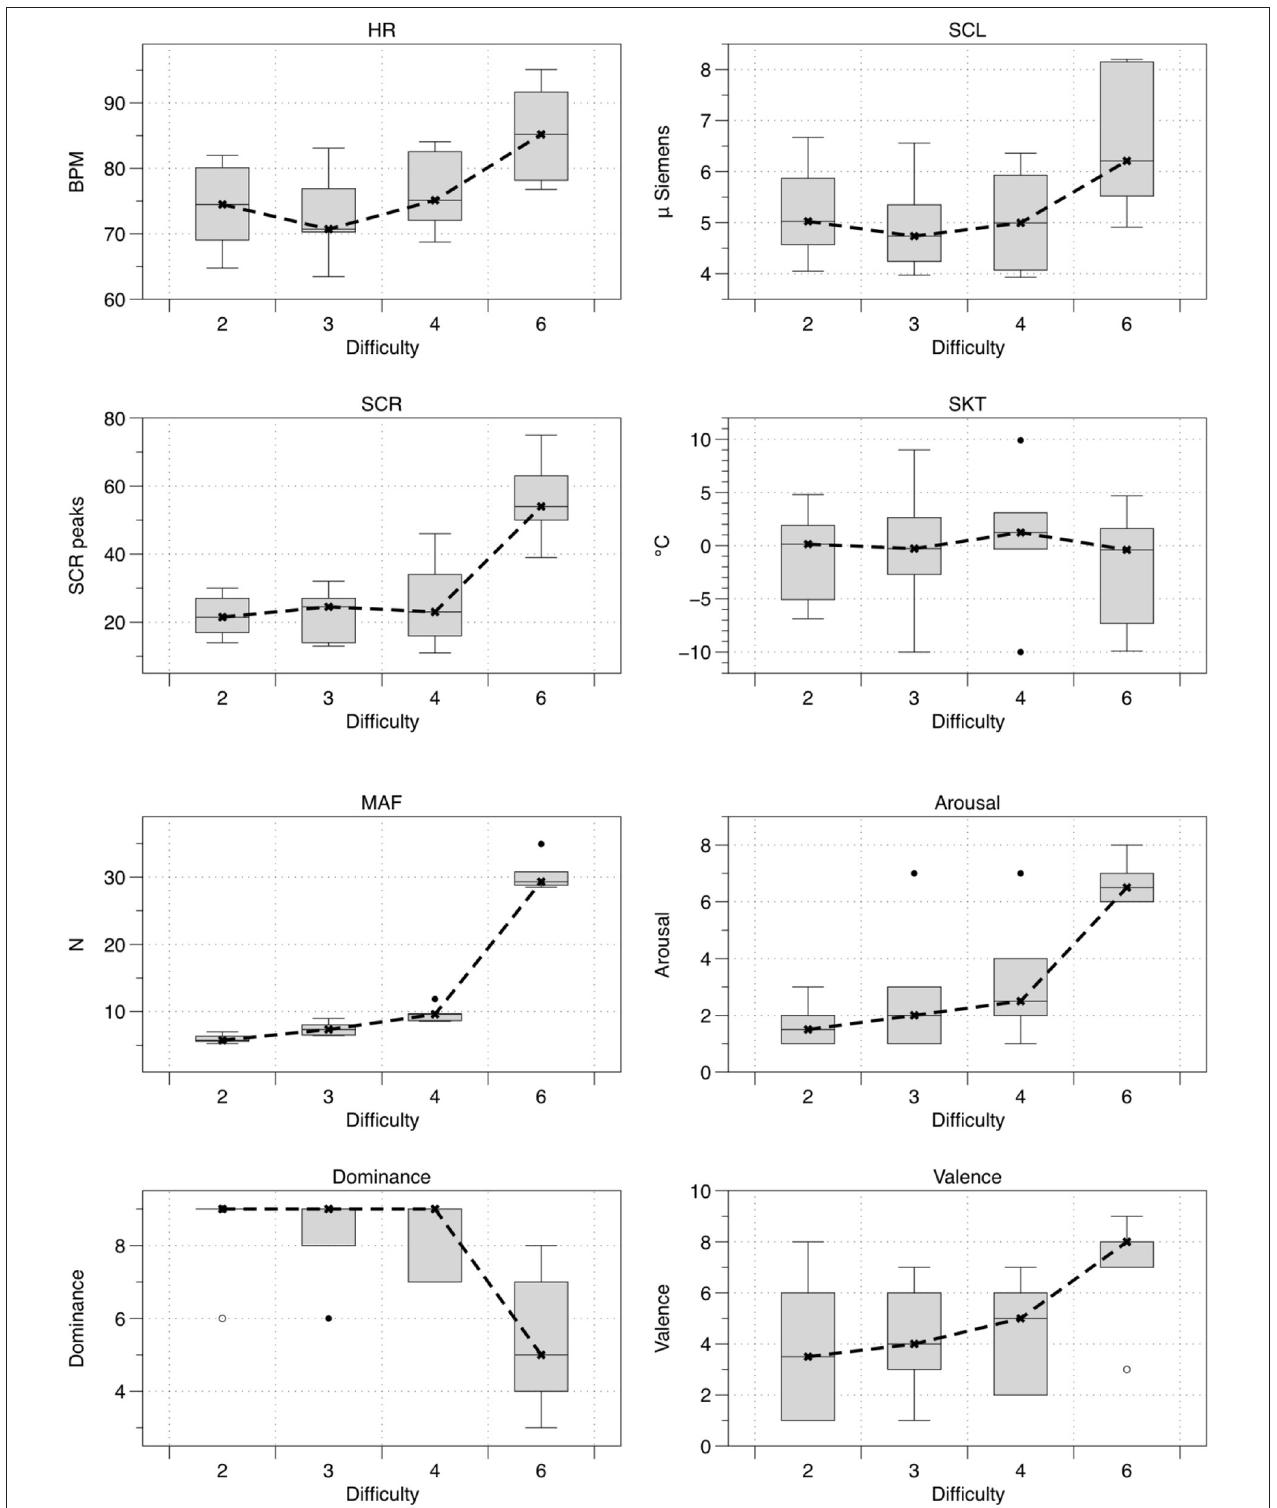
FIGURE 5 | Boxplots with mean values of HR, SCL, SCR frequency, SKT, MAF, arousal, dominance, and valence for the four levels of game difficulty ( n = 6). The shaded boxes represent the range in which 50% of the data fell (i.e., interquartile range). The “I” shaped whiskers represent all of the data that fell within 3 SD of the mean (i.e., the black horizontal bars). The open ( ◦ ) and closed ( • ) circles above the whiskers represent outliers (i.e., individual scores very different from the overall scores in the shaded box). Difficulty is presented in ascending order, although the presentation order in the experiments was 3, 4, 2, 6 (see Table 1 ).